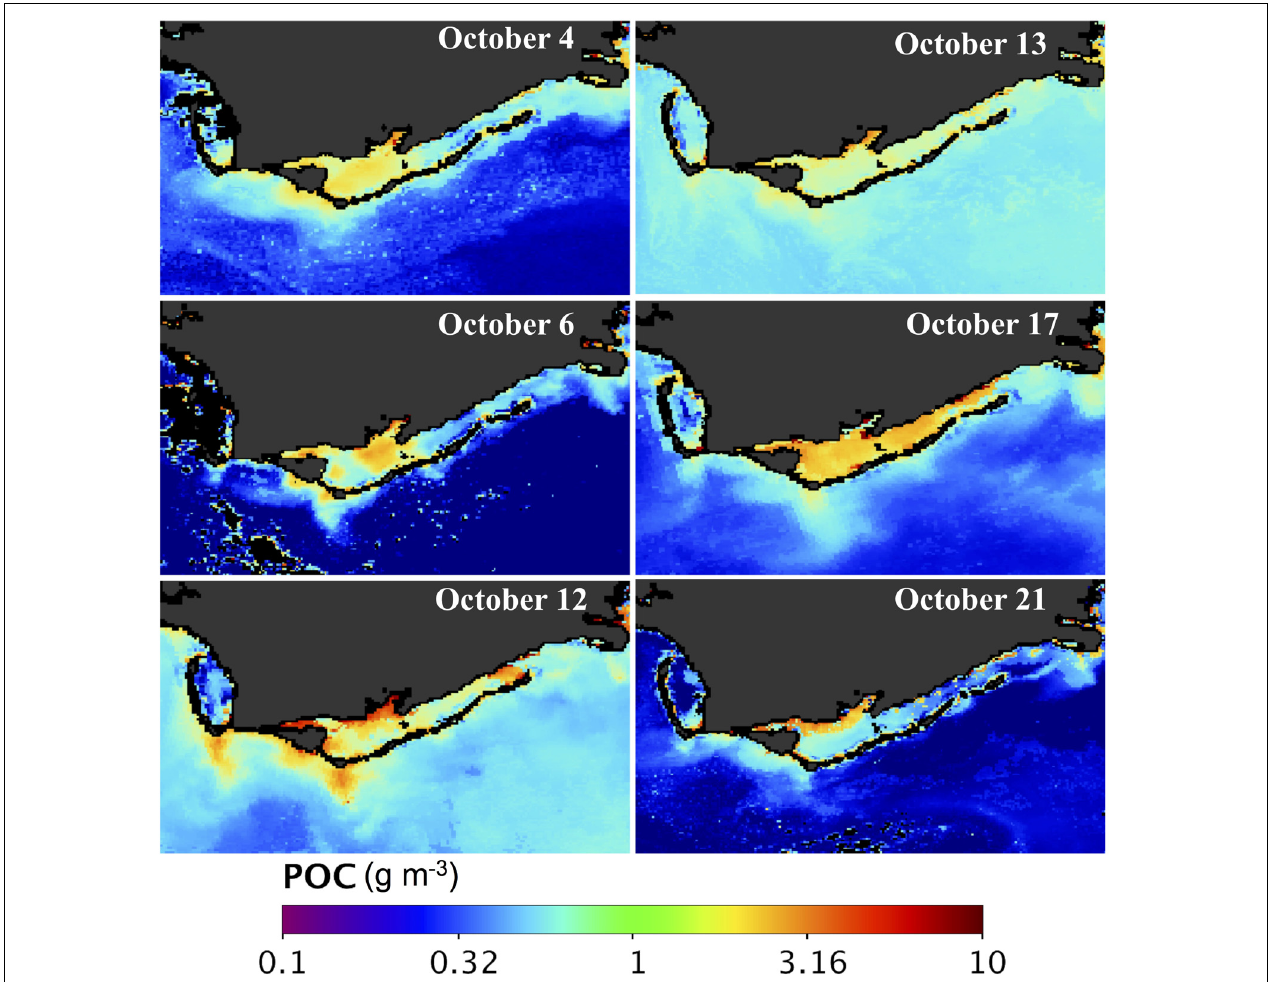
FIGURE 7 | POC maps of Apalachicola Bay. MODIS-derived POC maps (g m − 3 ) for October 4, 6, 12, 13, 17, and 21, 2018.